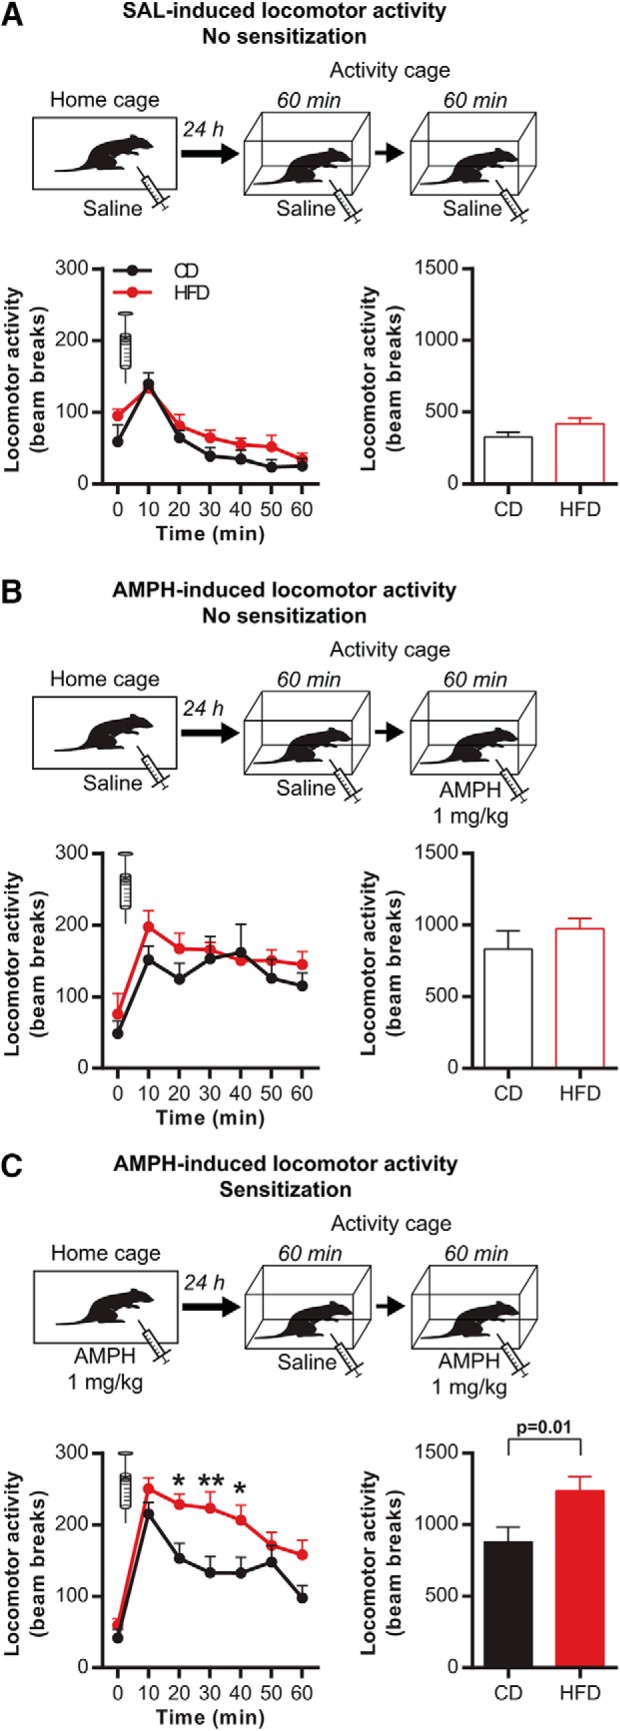

pHFD increases amphetamine-induced locomotor sensitization. A, Locomotor activity (photobeam counts) in response to saline was not affected by pHFD in nonsensitized animals (CD n = 12; pHFD n = 16). B, Locomotor activity in response to amphetamine was not affected by pHFD in nonsensitized animals (CD n = 7; pHFD n = 9). C, pHFD diet increased locomotor activity in response to amphetamine in sensitized animals (CD n = 11; pHFD n = 17). Left panels, Locomotor activity every 10 min. Right panels, Cumulative locomotor activity during 60 min. Syringes represent the time of amphetamine injection. Data are expressed as mean + SEM. *p < 0.05, **p < 0.01 diet effect.